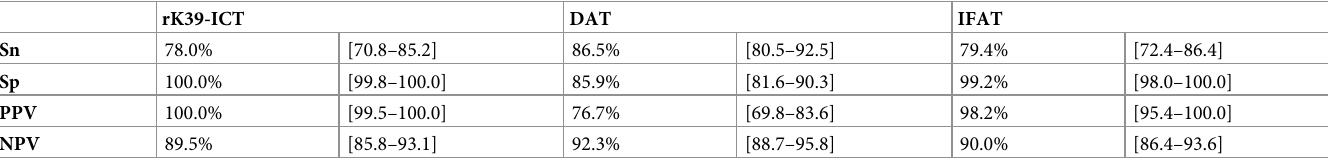
Table 2. Performance of rK39, DAT and IFAT on suspected visceral leishmaniasis samples in Spain, 2009–2015. Sensitivity (Sn), specificity (Sp), positive predictive value (PPV), negative predictive value (NPV) with 95% confidence intervals []. rK39-ICT DAT